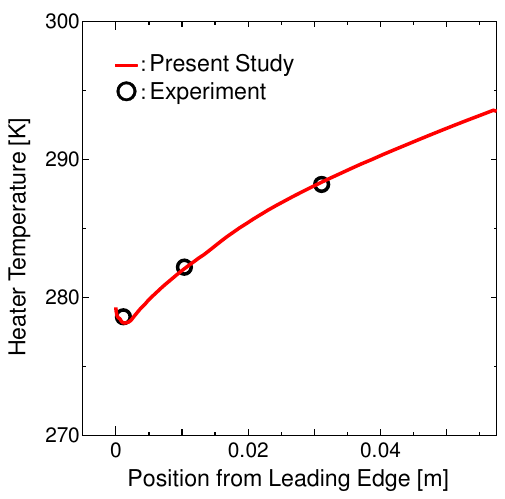
Figure 5. Heater temperature T heater distribution of NACA0013.